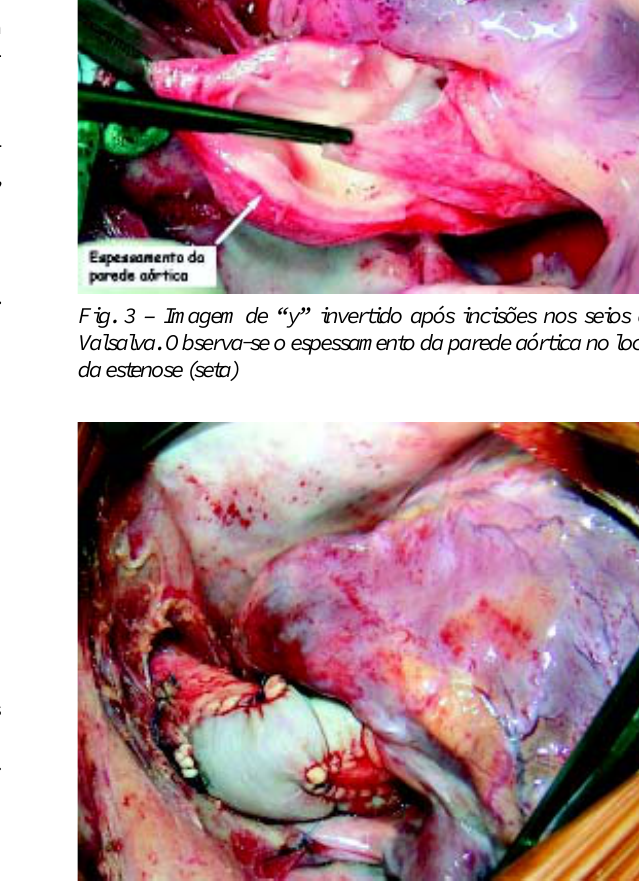
Fig. 4 – Ampliação da aorta ascendente com placa de pericárdio bovino em “y” invertido (técnica de